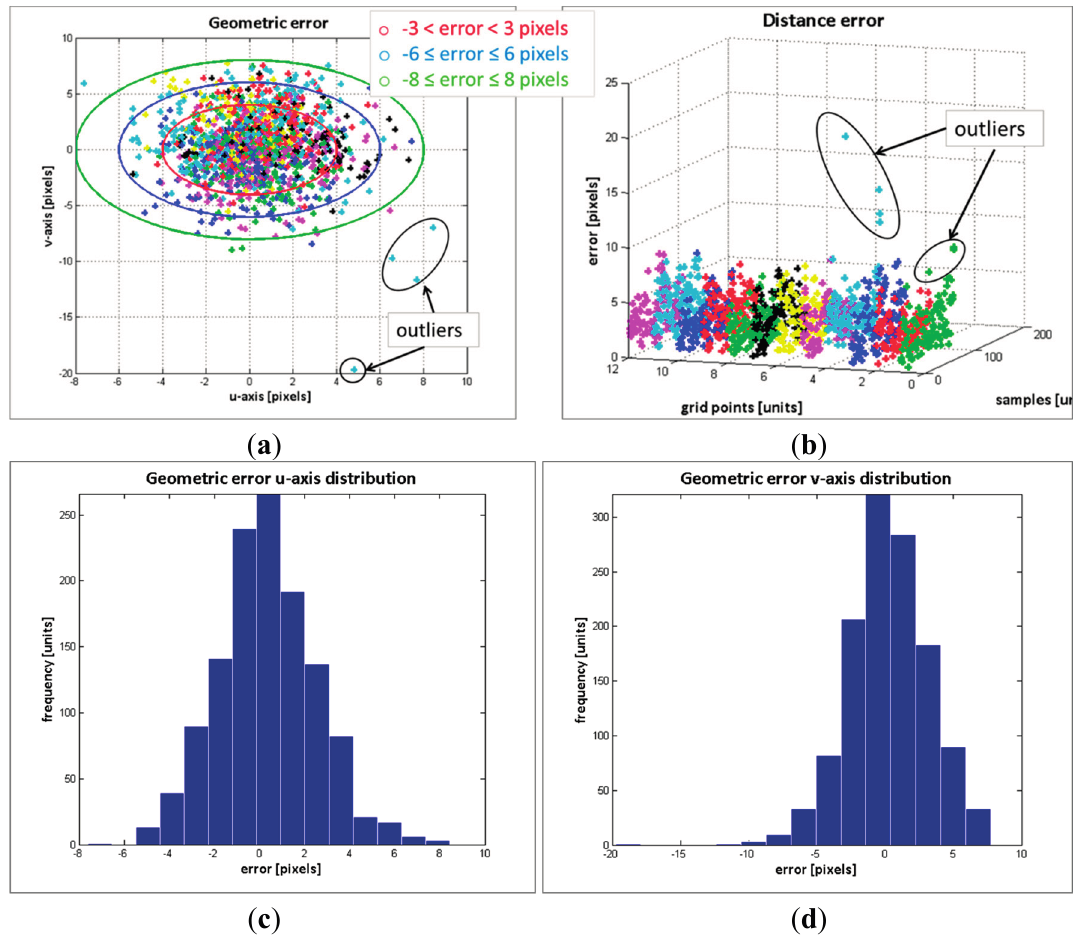
Figure 6. Geometric error evaluation. ( a ) geometric error; ( b ) distance error; ( c ) error distribution in u -axis; ( d ) error distribution in v